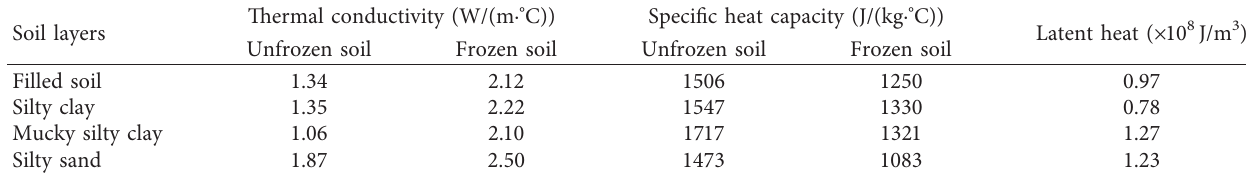
Table 3: Thermal physical parameters for different soil